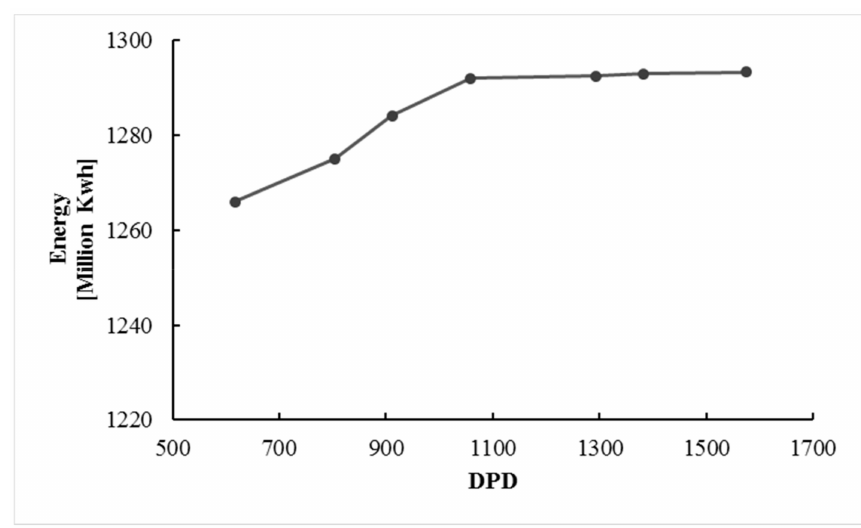
Figure 6. Trade-o ff between maximum annual hydropower production and DPD of various water shortage